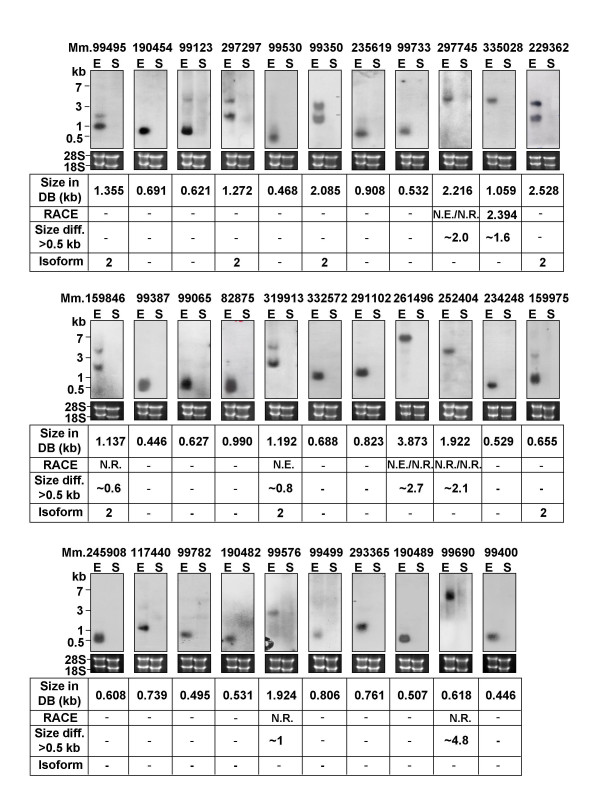
Transcript analysis by Northern-blot hybridization. Total RNA from epididymis (E) and spleen (S) were hybridized with cDNA probes of the genes. Agarose gels were stained with ethidium bromide to visualize 28S and 18S RNAs as a control to ensure loading of the same amount of RNA in each lane. There were significant differences in transcript size between the Northern blots and the UniGene predictions for eight genes, and these genes were subjected to RACE. This resulted in an additional new sequence for a gene (Mm.335028). Transcript sizes from known sequences (UniGene database and RACE), transcripts with significant differences in size between the Northern blots and cDNA sequences, and transcripts with isoforms are indicated below the blots. In the RACE analysis, genes with results in which transcript sequences were not extended (N.E.) or no result (N.R.), i.e. no amplification of transcript sequence in the analysis, are indicated. In the case of results from both 5'- and 3'-RACE in a given gene, the results are shown as 5'/3'.